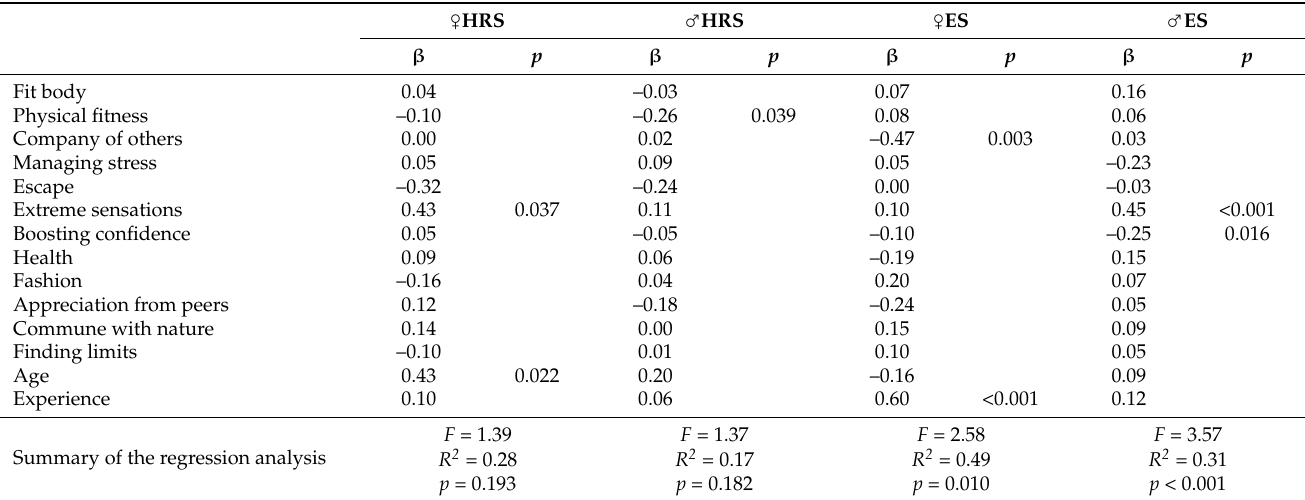
Table 3. Summary of regression analysis: importance of goals and satisfaction with life.